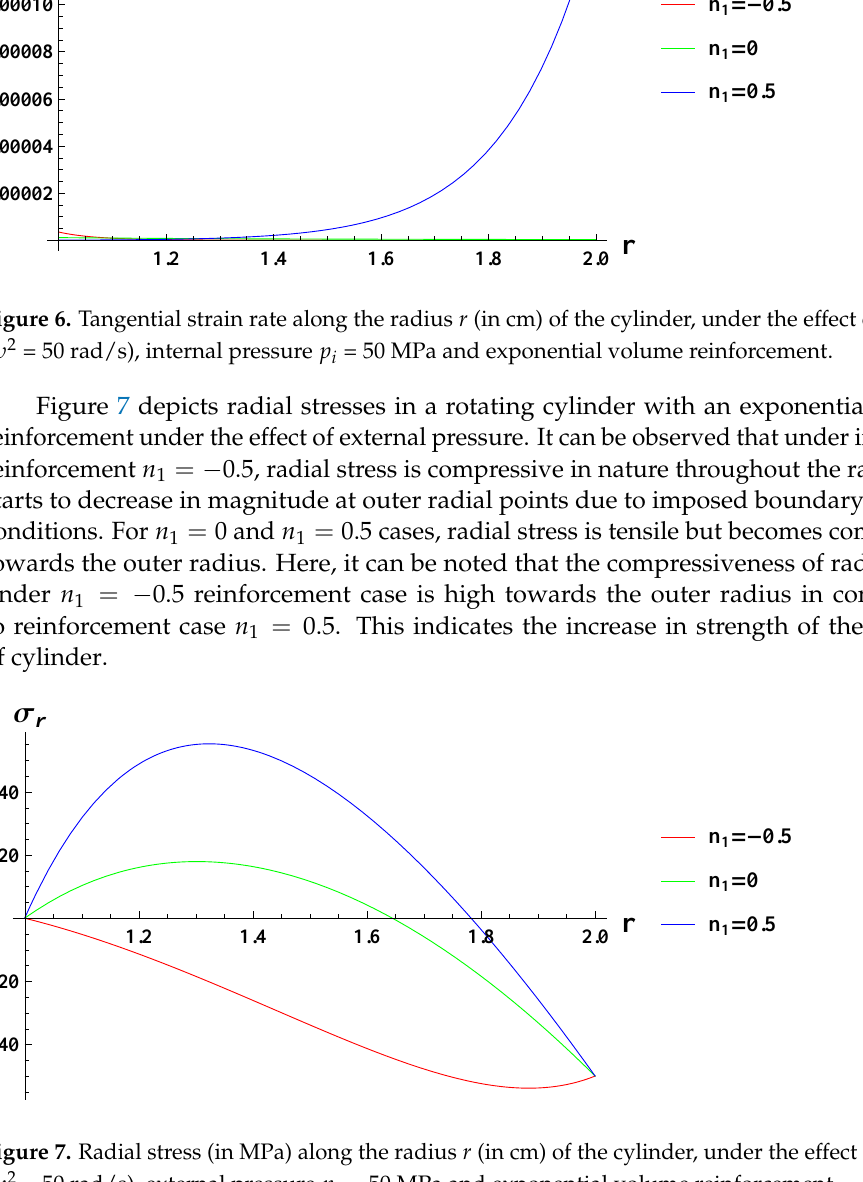
Figure 7. Radial stress (in MPa) along the radius r (in cm) of the cylinder, under the effect of rotation ( ω 2 = 50 rad/s), external pressure p o = 50 MPa and exponential volume